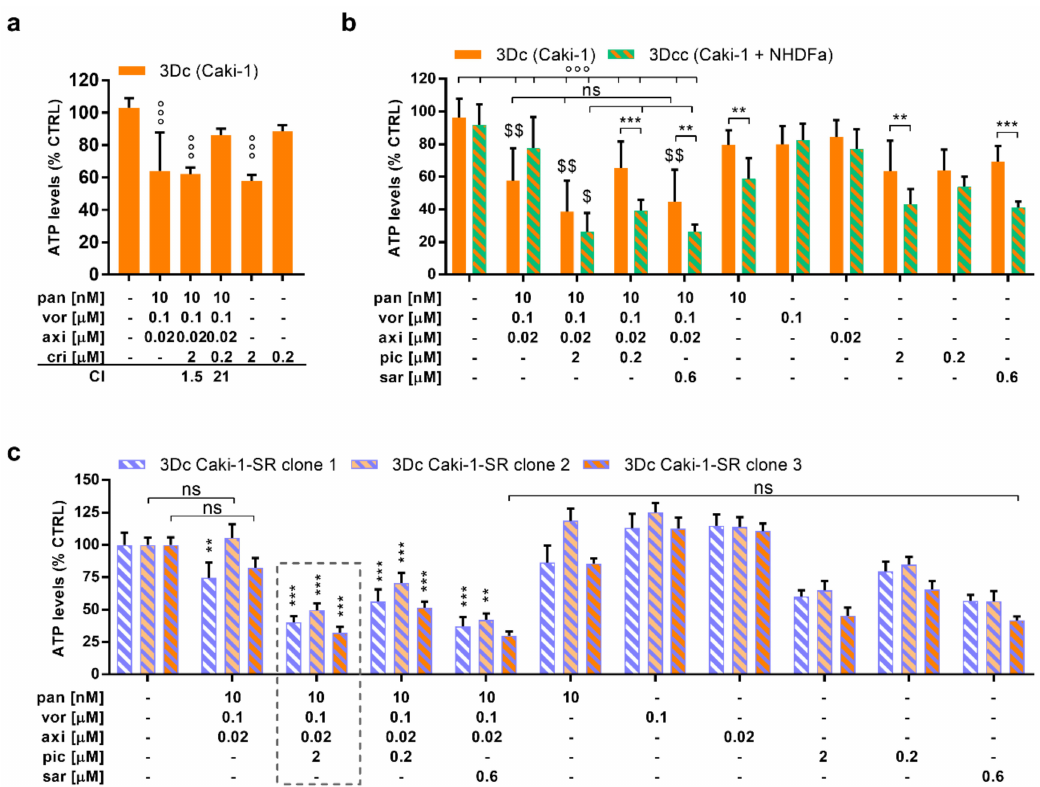
Figure 5. Activity of the multidrug combination after the addition of MAPK pathway-inhibiting drugs. ( a ) The activity of the multidrug combination of Caki-1 homotypic 3-D cultures (3-Dc) with and without the addition of crizotinib (cri) at two di ff erent doses. ( N = 3) ( b ) Combinations of the original ODC and MAPK pathway-inhibiting small molecule drugs tested in Caki-1 3-D cultures and 3-D co-cultures (3-Dcc) of Caki-1 and NHDF α cells ( N = 3). ( c ) Evaluation of the original ODC and other multidrug combination candidates supplemented with either pictilisib (pic) or saracatinib (sar) in three sunitinib-resistant Caki-1 clones ( N = 3). Error bars represent the SD and significance was determined with ( a , b ) a one-way ANOVA or ( c ) a two-way ANOVA and is represented with ** p < 0.01 and *** p < 0.001 vs. the CTRL and the monotherapies. ◦◦◦ p < 0.001 represents significance calculated vs. the CTRL only whereas $ p < 0.05 and $$ p < 0.01 represent significance calculated vs. the monotherapies only. ns, not